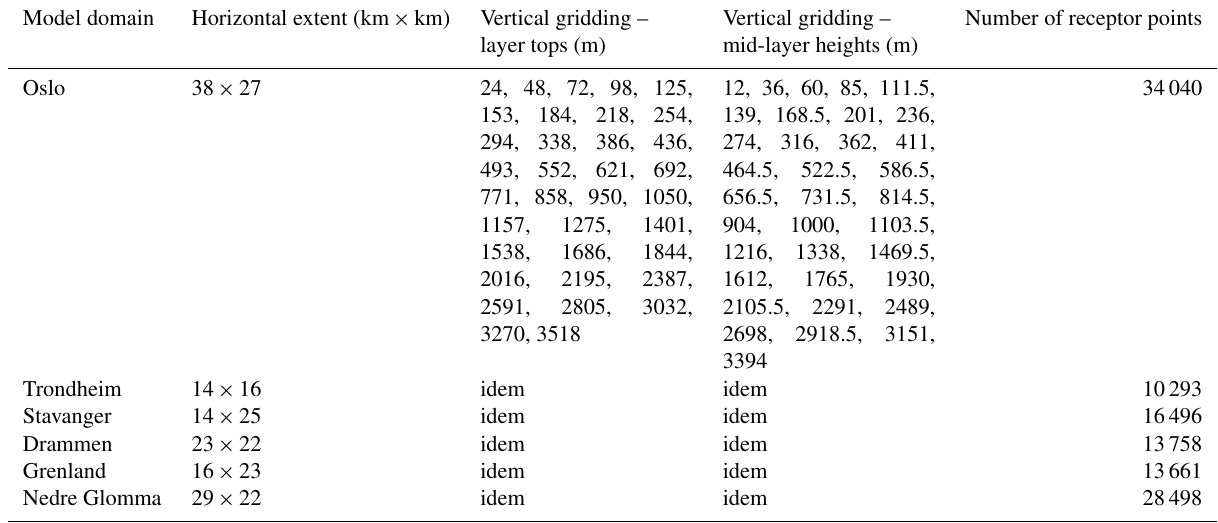
Table 6. A description of the horizontal extent, vertical gridding (shown as the height at the top and at the mid-level of each layer, with the mid-level points shown in brackets), and number of receptor points for each model domain. Note that identical vertical gridding was used for all six